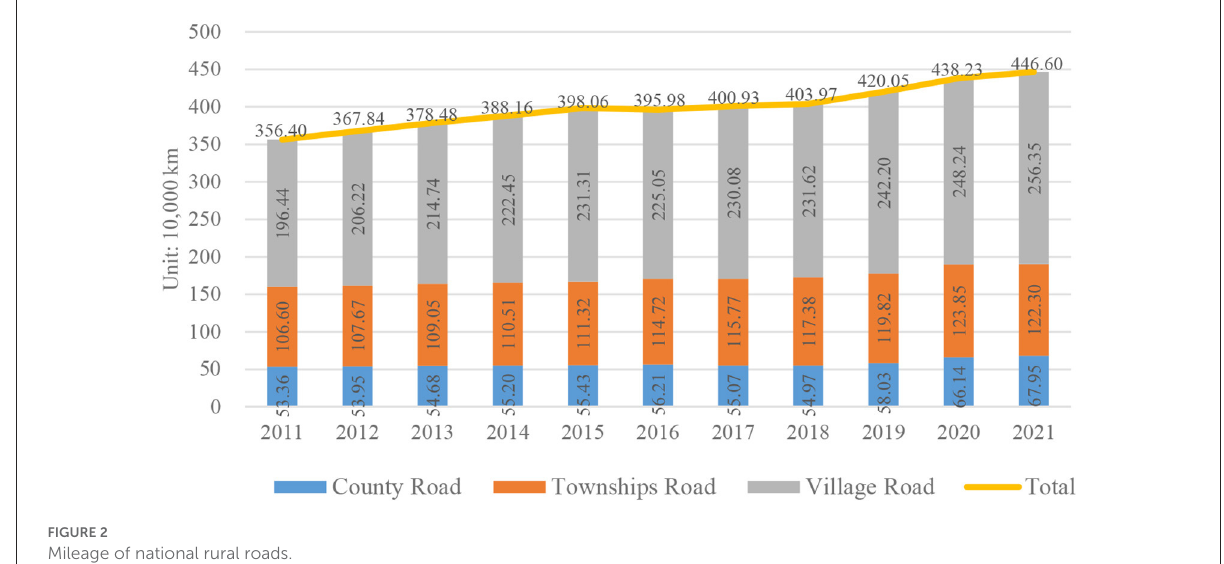
FIGURE2 Mileage of national rural roads.